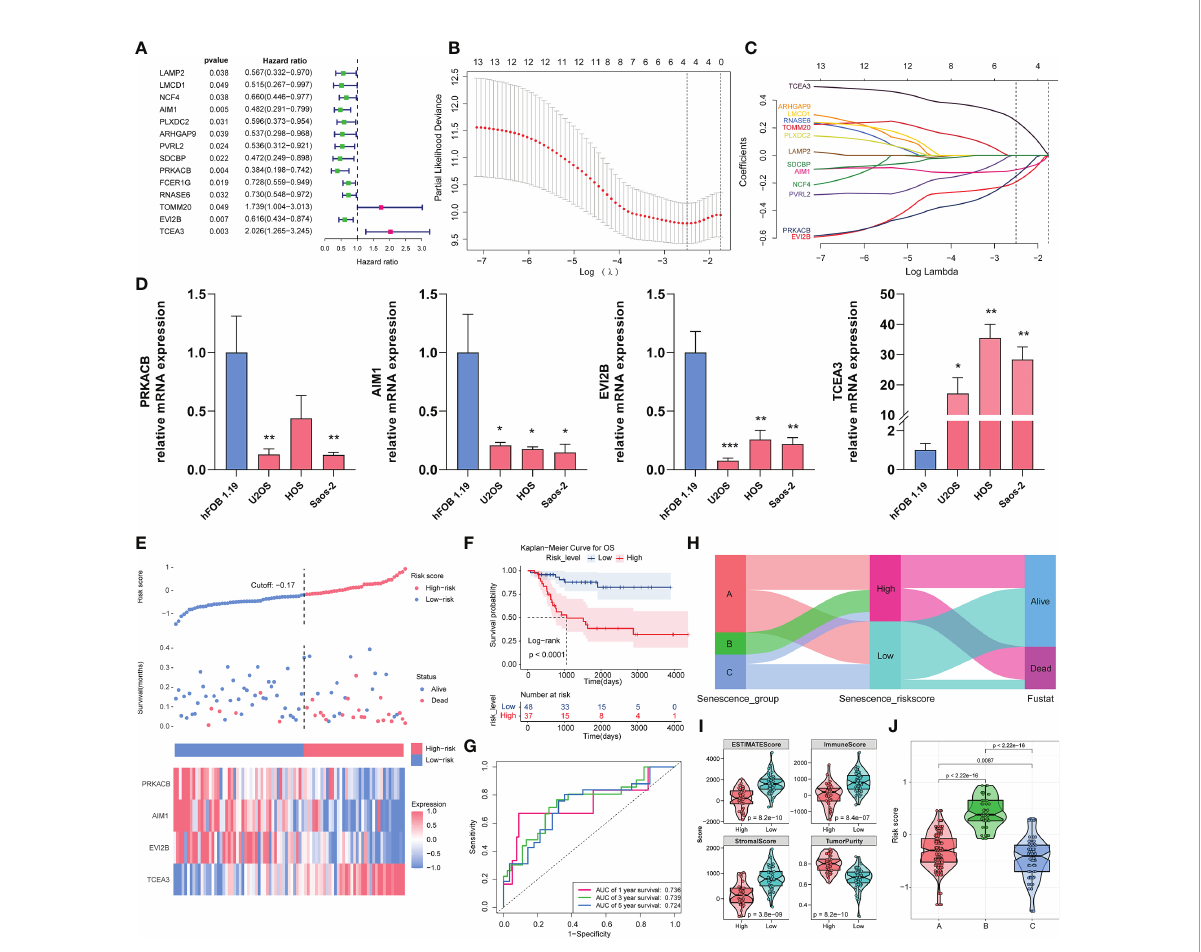
FIGURE 3 Construction of the risk model with the TARGET-OS cohort and validation with the validation cohort. (A) Through univariate Cox regression, the prognostic DEGs in the three clusters were screened. (B, C) LASSO regression analysis with optimal lambda. (D) Relative mRNA expression of PRKACB, AIM1, EVI2B and TCEA3 in different cell lines by qPCR. (*p < 0.05, **p < 0.01, ***p < 0.001. Not labeled: no statistical signi fi cance compared to hFOB 1.19). (E) Risk scores constructed from candidate genes, patient survival status, and expression heatmaps of the four candidate genes. (F) Survival curve of osteosarcoma patients in different risk groups. (G) ROC curve of the risk score model based on four candidate genes. (H) Relationship of the risk score grouping and survival status of the patients in the three subgroups. (I) ESTIMATE algorithm results for different risk groups. (J) Distribution of risk scores in the three